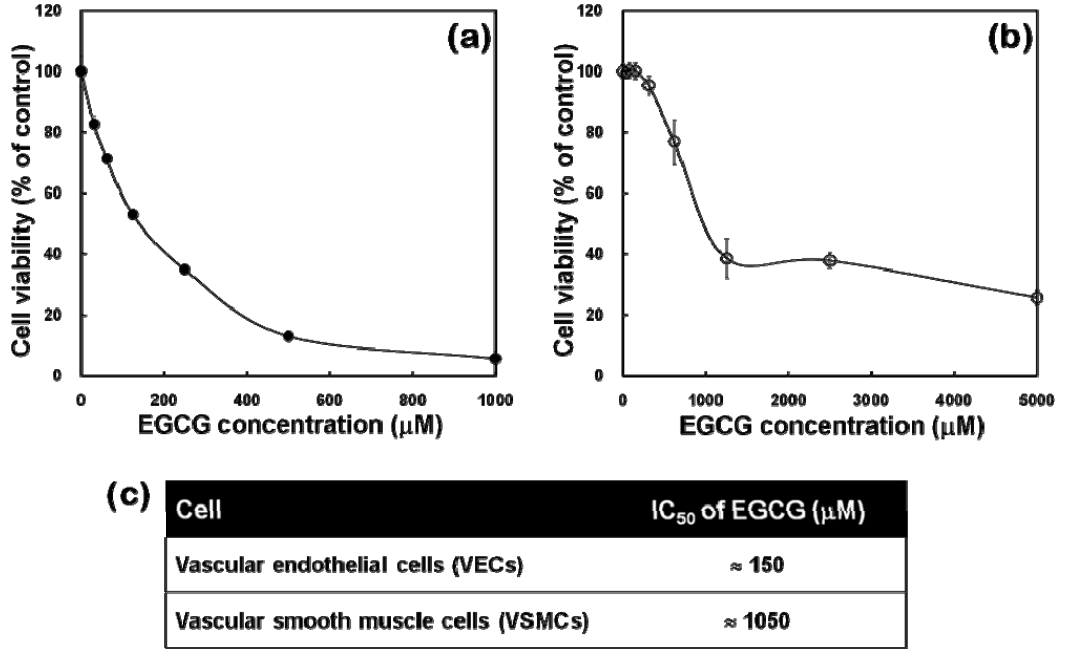
Figure 2. Cytotoxicity profiles of EGCG against cultured VECs (a) and VSMCs (b) . Cytotoxicity was measured by CCK-8 assay, as described in Experimental section. (c) IC values of EGCG to VECs and VSMCs were determined from their respective cytotoxicity